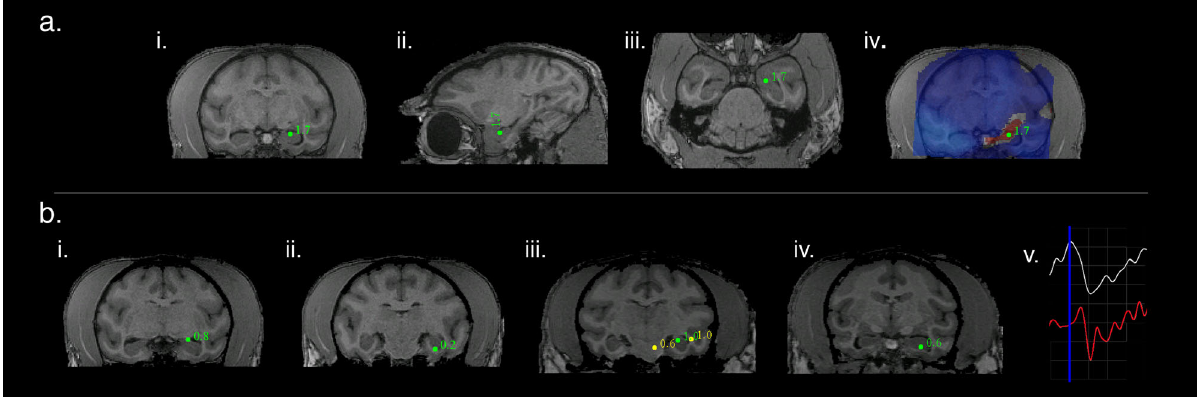
Fig. 3 SAM source localization of optogenetically evoked MEG responses in the left hippocampus. a SAM left hippocampal peak in coronal ( i ), sagittal ( ii ), and axial planes ( iii ) for a 20 Hz sine wave input in NHP M3. The whole brain, un-thresholded, SAM SPM shows synchronized activity arising from the stimulation site and surrounded by desynchronization ( iv ). b Left SAM hippocampal peaks for four additional and different stimuli in two different NHPs (M1 and M3). ( bi – ii ) is the same subject (M3) as presented in ( a ); ( i ) and ( ii ) show hippocampal peaks for single 150 ms ramp trials or 10 ms square pulses, respectively. ( biii – iv ) show hippocampal peaks for 8 Hz or 40 Hz sine waves, respectively, in the same subject (M1) as in Fig. 2a. A single trial ( v ) of a simultaneous LFP and SAM virtual electrode (both from 1 to 35 Hz) for hippocampus (as seen in bi ). Blue vertical line indicates stimulus onset (ramp inputs). Both the LFP (white) and virtual electrode (red) peak rapidly following stimulation and have similar features and time courses. One gray square = 50 ms (abscissa) and 5 V for the LFP (ampli fi ed) or 500 nA m for the virtual electrode